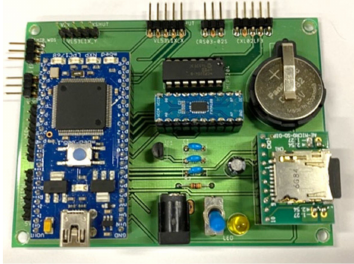
Figure 7. Control system